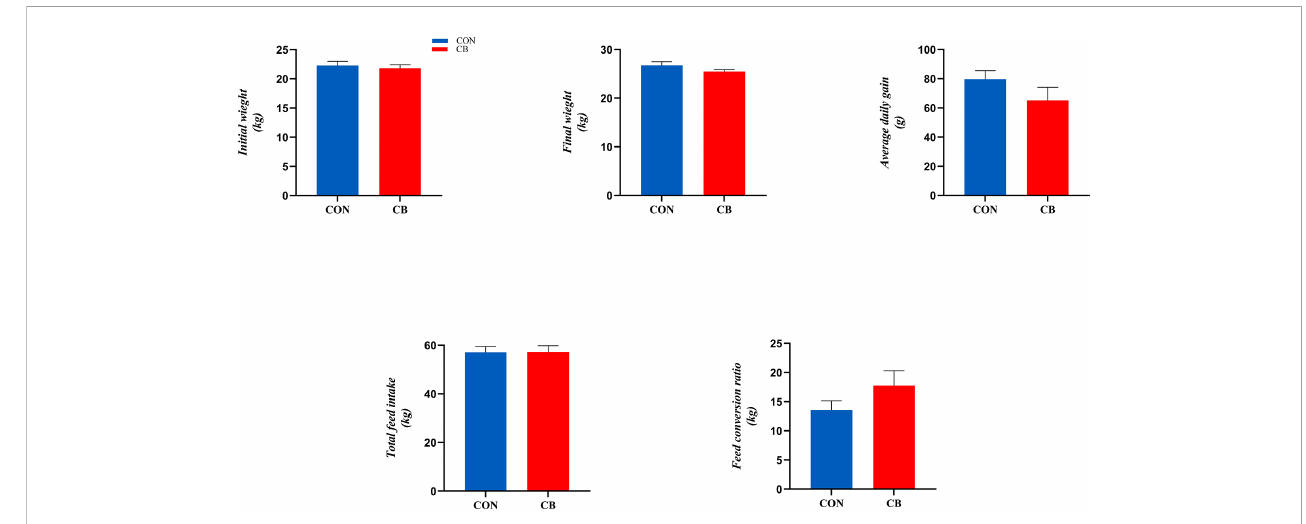
FIGURE 1 Effect of supplementation of C. butyricum in the diet on growth performance of